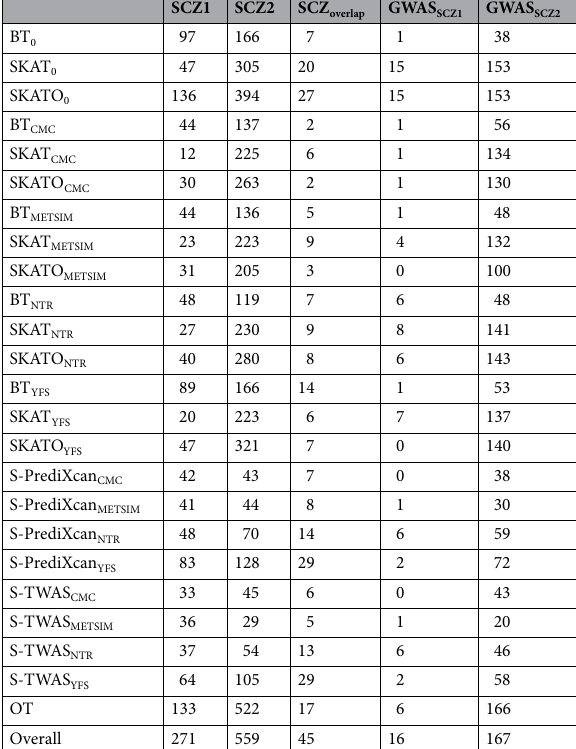
Table 3. The numbers of genes identified by each method for the two SCZ data sets. The subscript denotes BT, SKAT, and SKATO using eQTL—derived weights; CMC, METSIM, NTR, and YFS indicate the resources to obtain the eQTL—derived weights. 0 indicates the methods without using any weights. SCZ1 indicates the number of genes identified by each method for SCZ1 data; SCZ2 indicates the number of genes identified by each method for SCZ2 data; SCZ overall indicates the number of overlapping genes identified by both SCZ1 and SCZ2 data sets; GWAS SCZ1 and GWAS SCZ2 indicate the numbers of genome-wide significant genes that are reported in the GWAS catalog and are also identified by each method for SCZ1 and SCZ2, respectively.